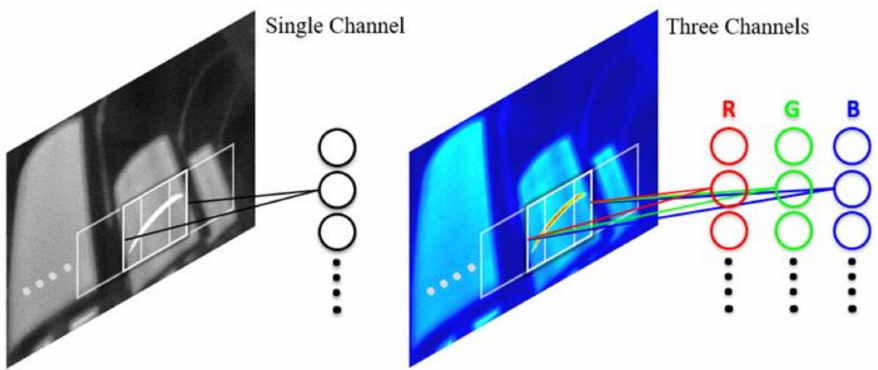
Figure 16. The difference between the grayscale image and color